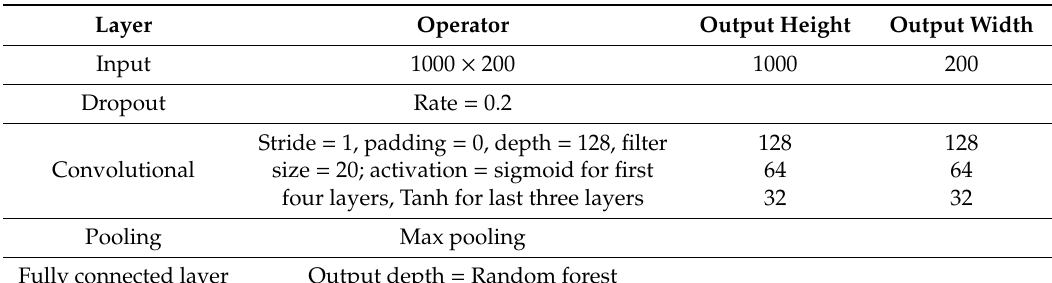
Table 4. The configuration of the BCR